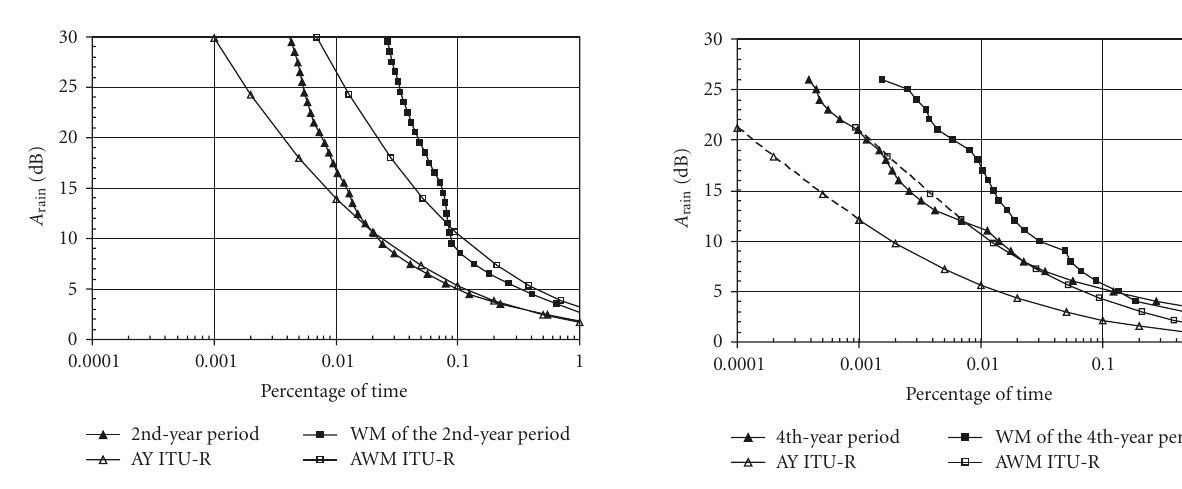
Figure 9: CDs of rain attenuation obtained for the second-year pe- riod.